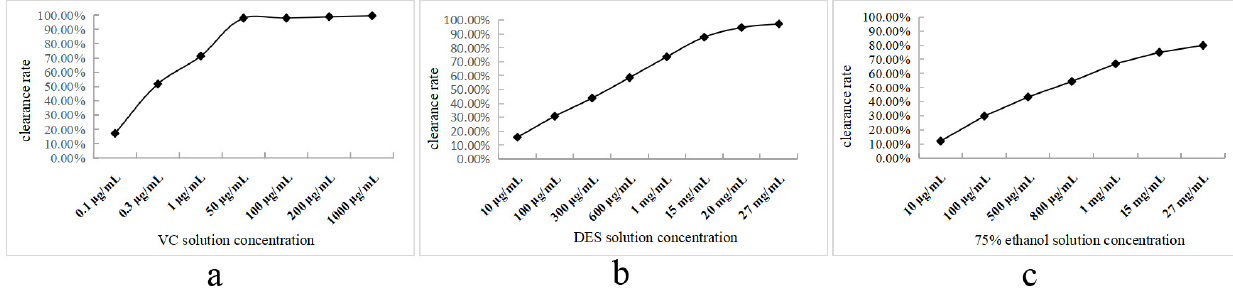
Figure 11. Comparison of DPPH radical scavenging activity in different solutions. ( a ) VC reference solution; ( b ) DES solution; ( c ) 75% ethanol solution.